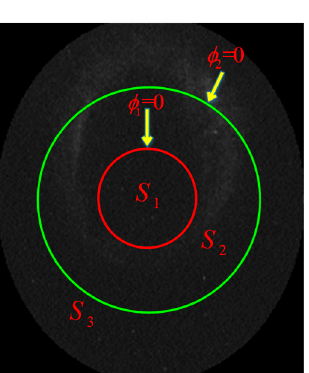
Figure 3. The three regions divided by φ 1 and φ 2